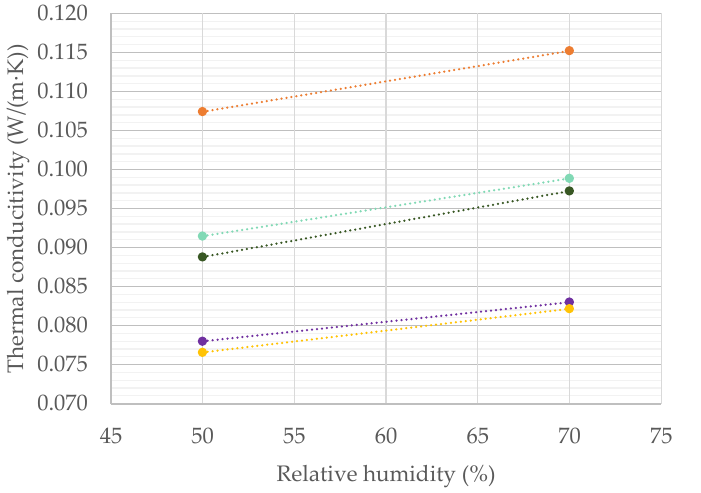
Figure 4. Correlation between thermal conductivity and RH of the tested bio-wastes.